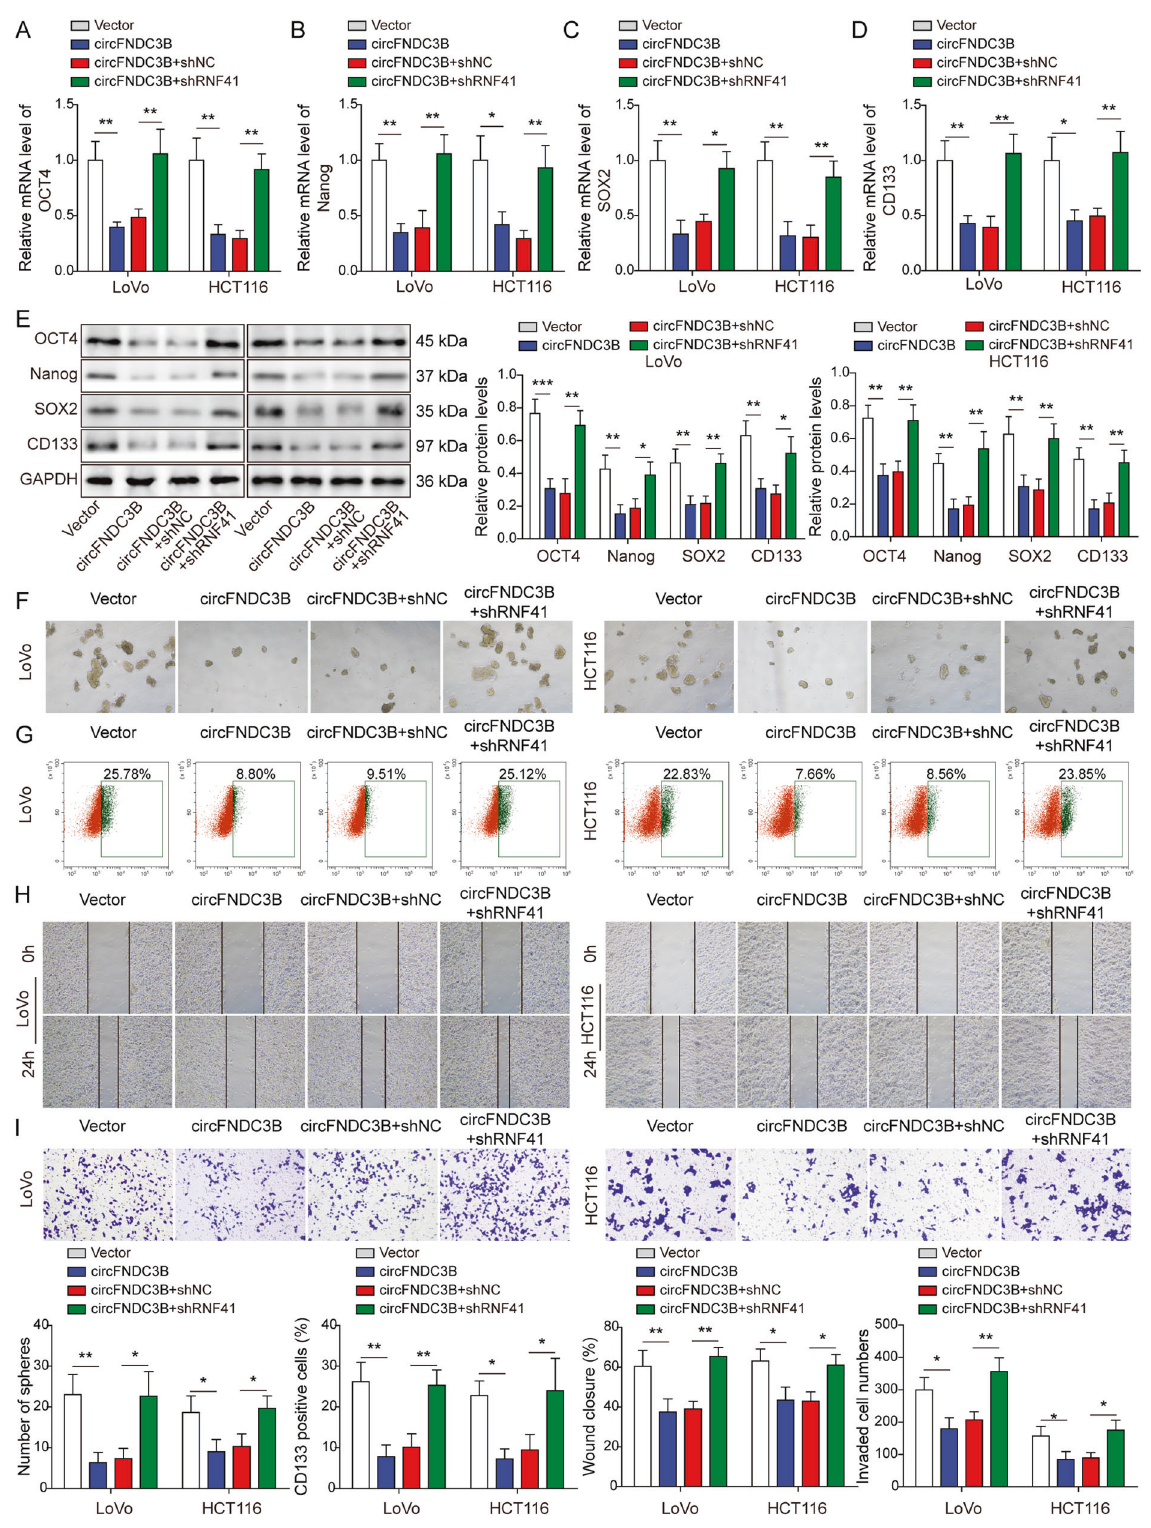
Fig. 5 Knockdown of RNF41 counteracts circFNDC3B-suppressed CRC stemness and metastasis. A – E The expression of stemness markers were detected by qRT-PCR and Western blotting. F Representative sphere images of transfected CRC cells with quantitative analysis. G CD133 + cells were analyzed by fl ow cytometry with quantitative analysis in transfected CRC cells. H Cell migration was monitored by wound healing assay with quantitative analysis in transfected CRC cells. I Cell invasion was measured by Transwell invasion assay with quantitative analysis. * P < 0.05, ** P <